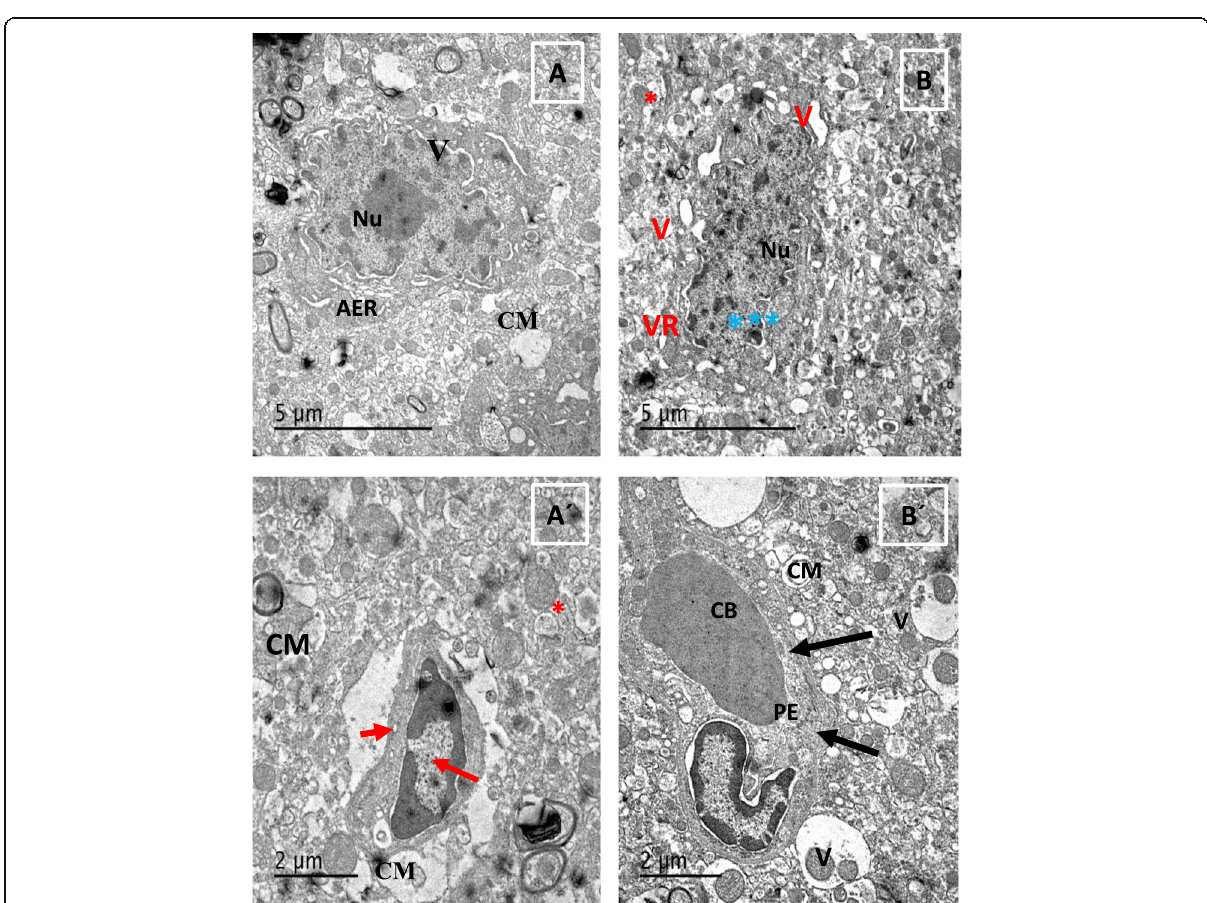
Fig. 7 Transmission electron microscope of brain section in ASP-LD and ASP-HD groups. a ASP-LD group showing junctions between capillary wall and neuropil (red arrow) with tight wall without any disintegration or edema. Pyknotic Purkinje cells appeared with irregular boundaries and abundant crystallizes mitochondria (CM) as well as fragmented rough endoplasmic reticulum (RER). Disintegration junction capillary wall between the capillary wall and astrocytic perivascular edema (PE) with the appearance of more vacuoles and vesiculated rough endoplasmic reticulum (VR). b TEM section of group treated with ASP-HD showing Purkinje cell with karyolysed nuclei and apoptotic appearance with irregular boundaries and convolution of the nuclear envelop with disintegration of unclear chromatin (***) having cytoplasm with very reduced mitochondria (*) and some crystalizes (CM) and modified cytological structures, the capillary junction between the capillary wall and astrocytic perivascular edema (PE) and thickening if the junction wall (black arrow) with very abnormal convolution appearance and congested blood vessels (CB) with moderate hemorrhage and appearance of more